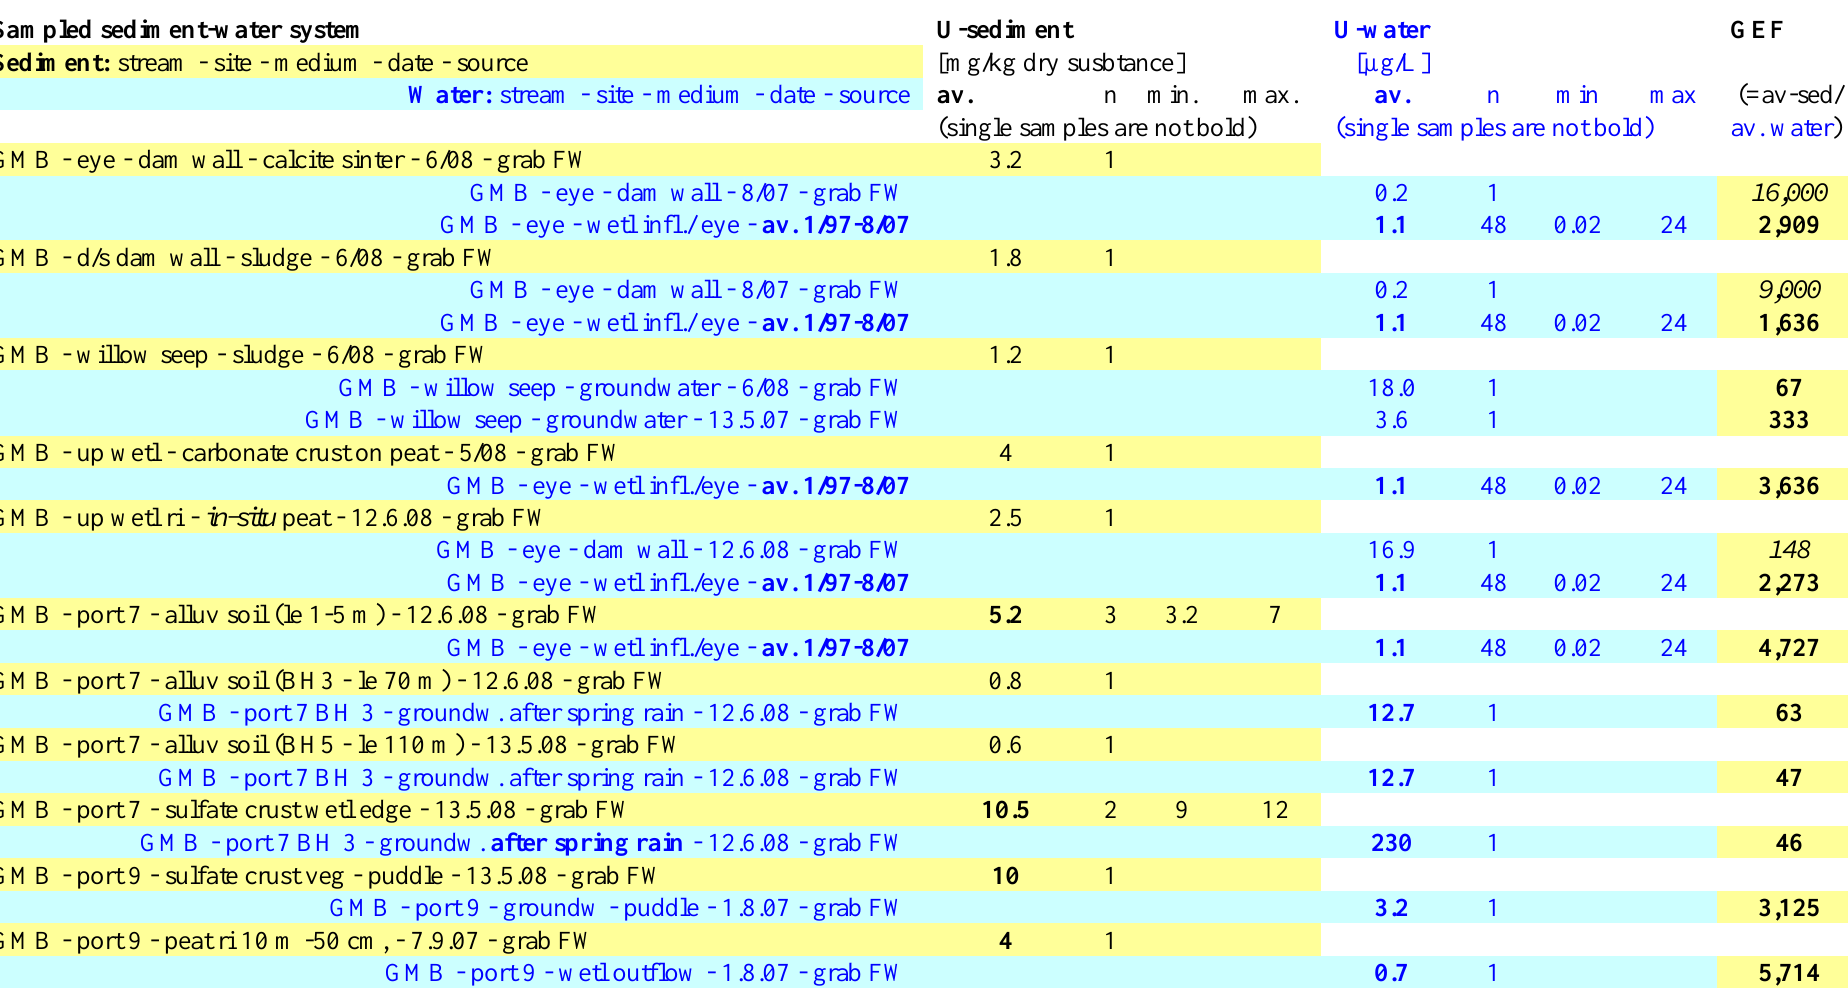
Table 3. Geochemical enrichment factors (GEF) for different water-sediment systems in the GMB wetland. GEFs printed in italics are based on single grab water sample rendering them unreliable. Where available, therefore, long-term average U concentrations in the corresponding water body are preferentially used for interpretation (GEFs are printed in bold